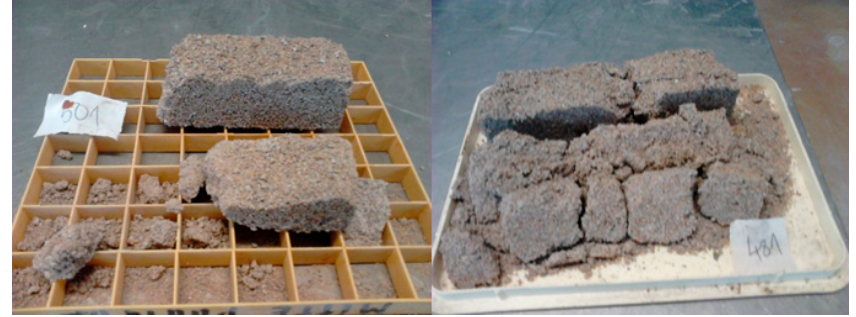
Figure 7. Spontaneous disintegration of EN280 specimens after 60% RH curing.